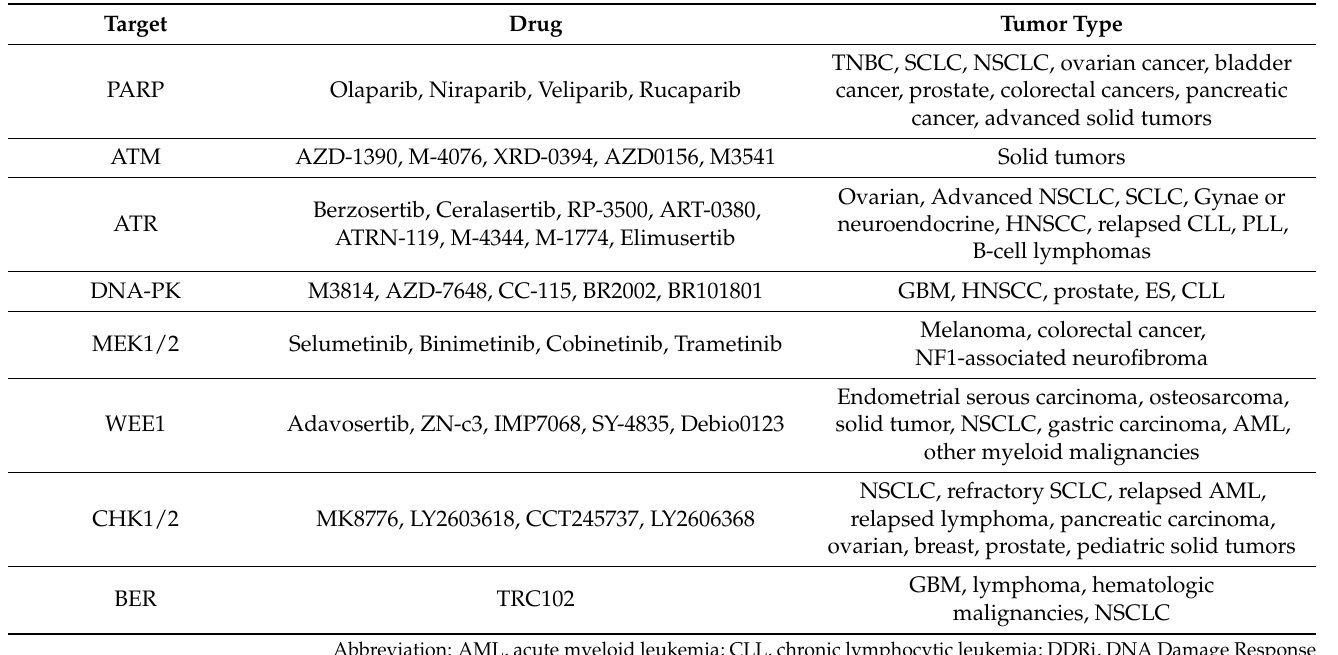
Table 1. DDR inhibitors in clinical